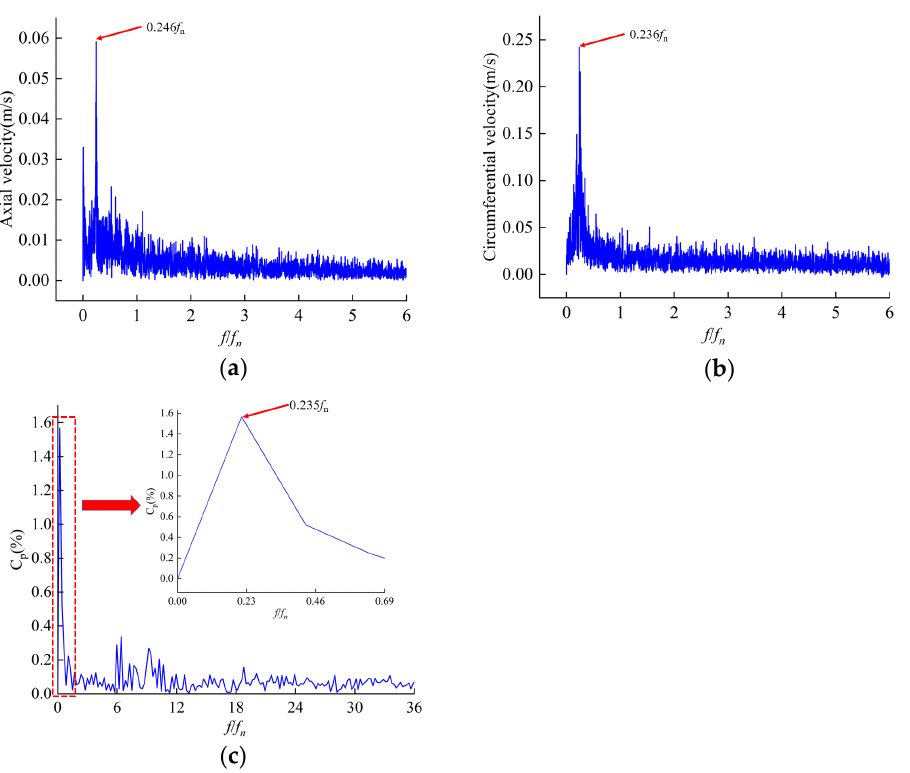
Figure 19. FFT result at OP4 (LDV measuring point position is 0.2 R). ( a ) Axial velocity, ( b ) circumferential velocity, and ( c ) pressure pulsation.